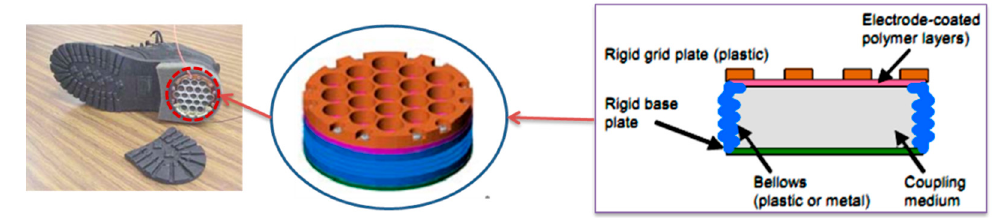
Figure 4. Dielectric elastomer powered boot generators [43].